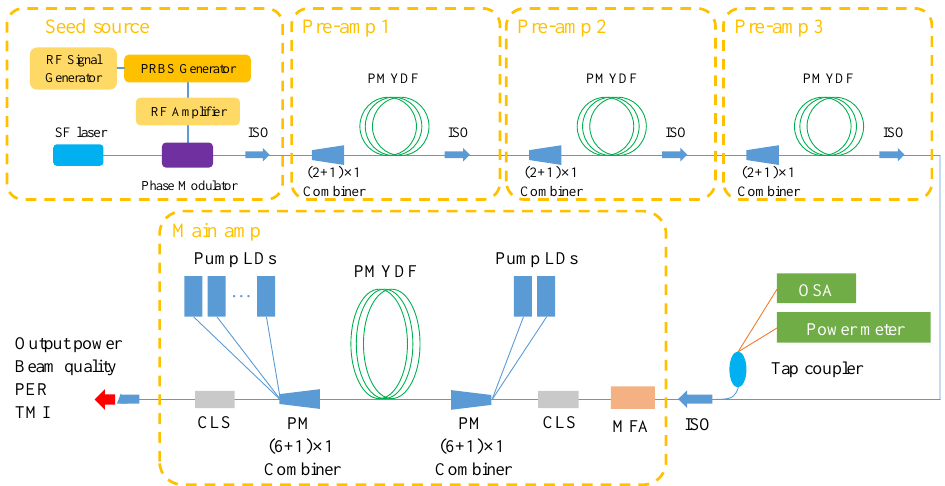
Figure 1. Experimental setup of the all-PM fiber amplifier. SF laser, single frequency laser; PMYDF, polarization-maintaining Yb-doped fiber; ISO, isolator; CLS, cladding light stripper; LD, laser diode.